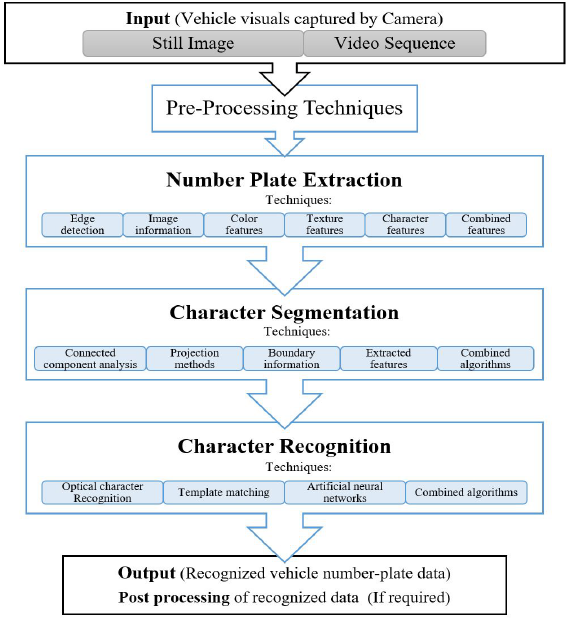
Figure 2. General processes of number plate recognition